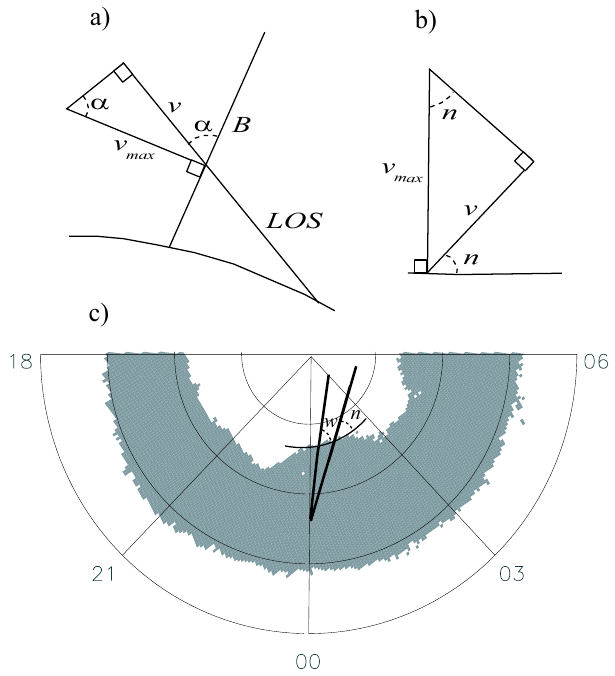
Fig. 3. The angles to consider when estimating the ion flow perpen- dicular to the magnetic field and the open-closed boundary. ( a ) α is the angle between the magnetic field line and the measured line- of-sight flow velocity. ( b ) n is the angle between the open-closed boundary and the north beam of the EISCAT VHF radar. ( c ) All counts above the noise threshold of FUV WIC (21:59:57 UT) are shown in grey. The straight solid lines show the west and north beam of the EISCAT VHF radar and the curved solid line shows the smooth open-closed boundary along the two line of sights. The angles between the line of sight and the boundary for the west and north beam are denoted w and n , respectively. In a) and b) we have indicated the maximum velocity given this